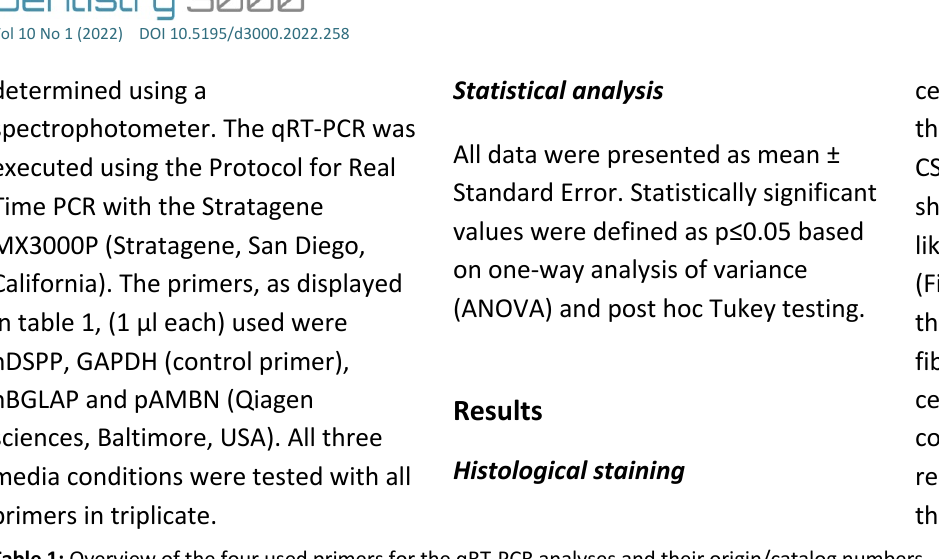
Table 1: Overview of the four used primers for the qRT-PCR analyses and their origin/catalog